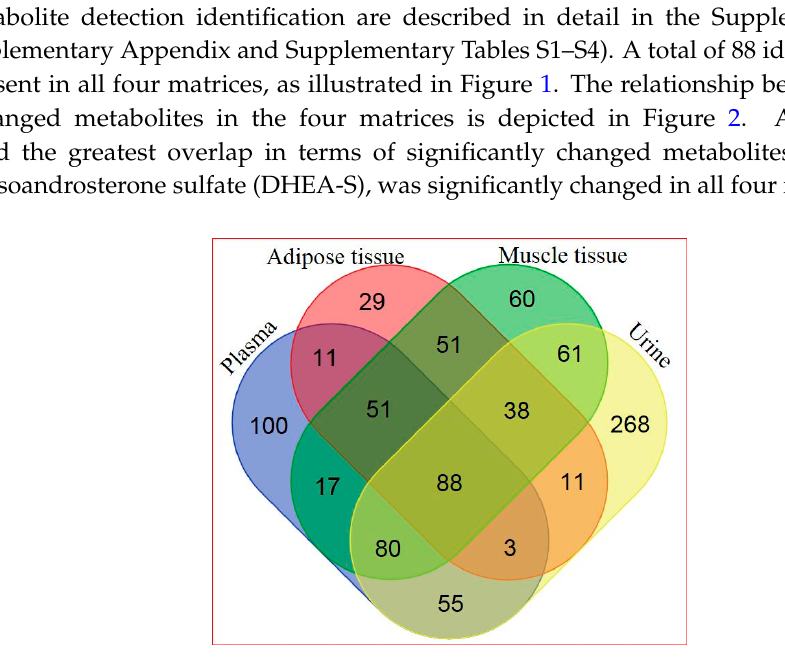
Figure 1. Venn diagram of all detected metabolites in the four different matrices (for metabolite details see Supplementary Table S5).